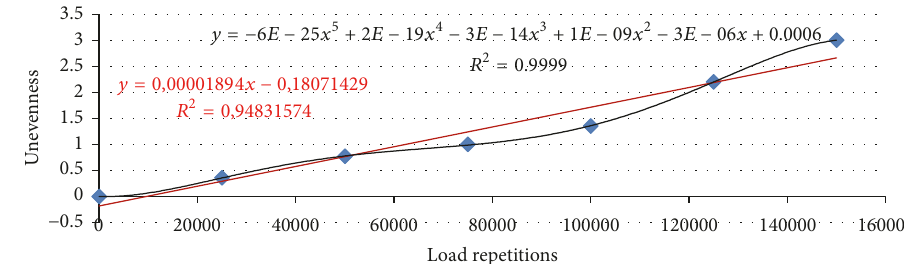
Figure 8: Transversal unevenness on the experimental pavement section.